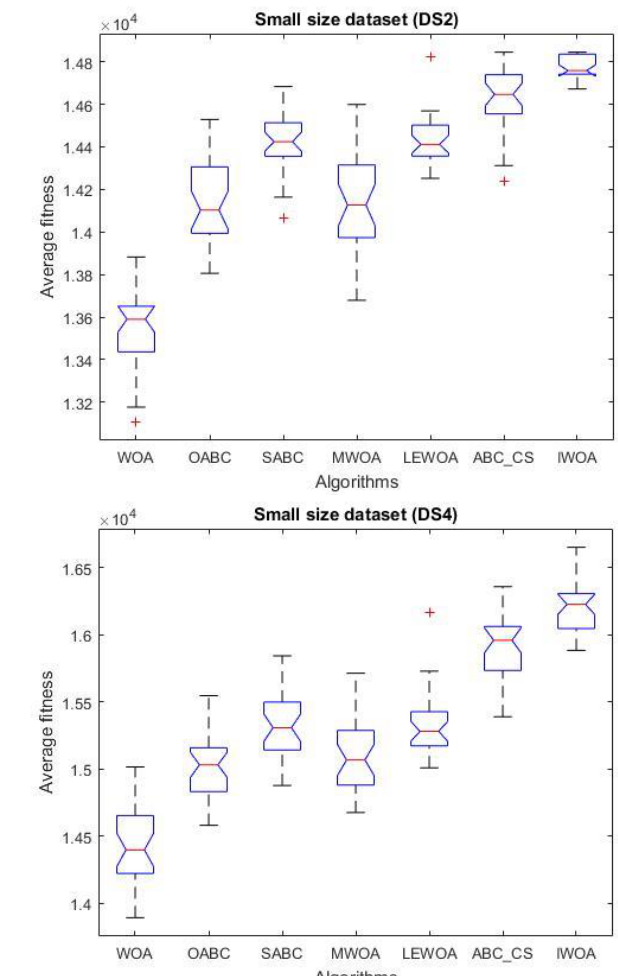
Figure 3. Boxplots for the average fitness value obtained using the compared algorithms for the medium size dataset.